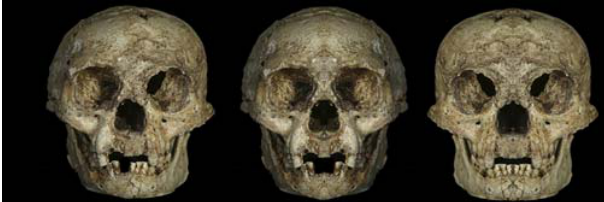
Figure 1. Three Faces of LB1 The image on the left shows LB1’s actual skull. The other two photos are composites made by dividing right and left sides at the midline and mirroring each side to yield two photos displaying obvious differences in right and left side facial architecture. (Photo left: Etty Indriati. Photos center and right: DW Frayer. Courtesy of Proceedings of the National Academy of Sciences of the United States of America, used with